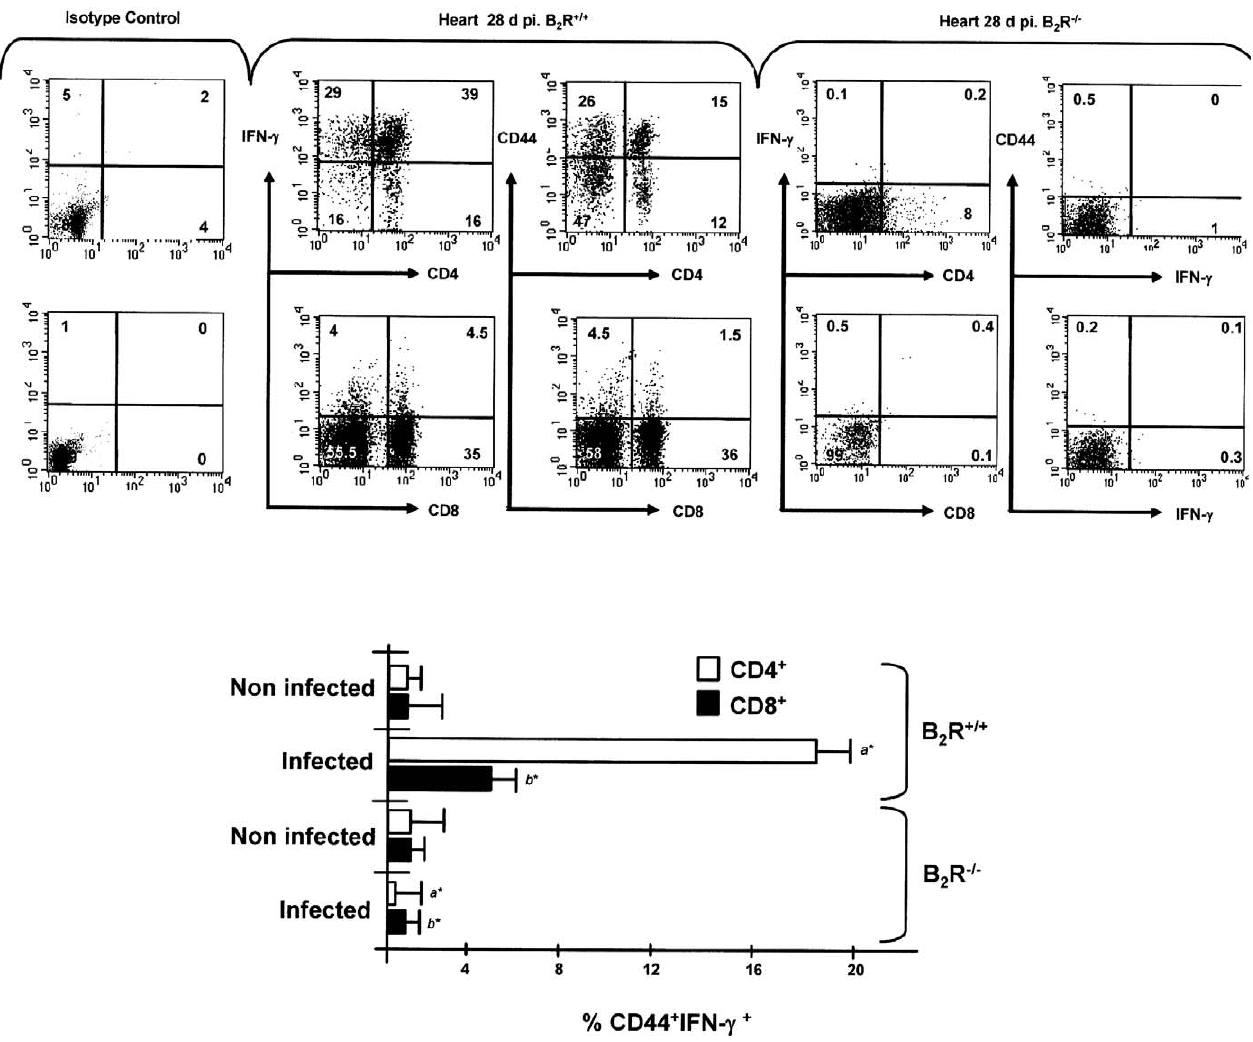
Figure 5. B 2 R (cid:2) / (cid:2) -Infected Mice Display Negligible Frequencies of Heart-Derived CD4 þ and CD8 þ -Activated T Cells at Advanced Stages of Acute Infection Heart-derived T cells were stimulated with T. cruzi Ag (25 l g/ml) for 18 h at 37 8 C and were stained for CD4 or CD8, IFN- c , and CD44 marker as described in Materials and Methods. Cells from B 2 R þ / þ mice were gated on CD4 þ IFN- c þ or CD8 þ IFN- c þ lymphocytes and examined for expression of CD44. Dot plot profiles ( n ¼ 5 mice/group) are representative of results observed in two independent experiments. Column graphs (lower panel) indicate the mean 6 SD of the frequency of IFN- c -producing CD4 þ CD44 þ or CD8 þ CD44 þ T cells ( n ¼ 2). Statistics were done by ANOVA and pair-wise comparisons were done by the Tukey tests (*, p , 0.01).